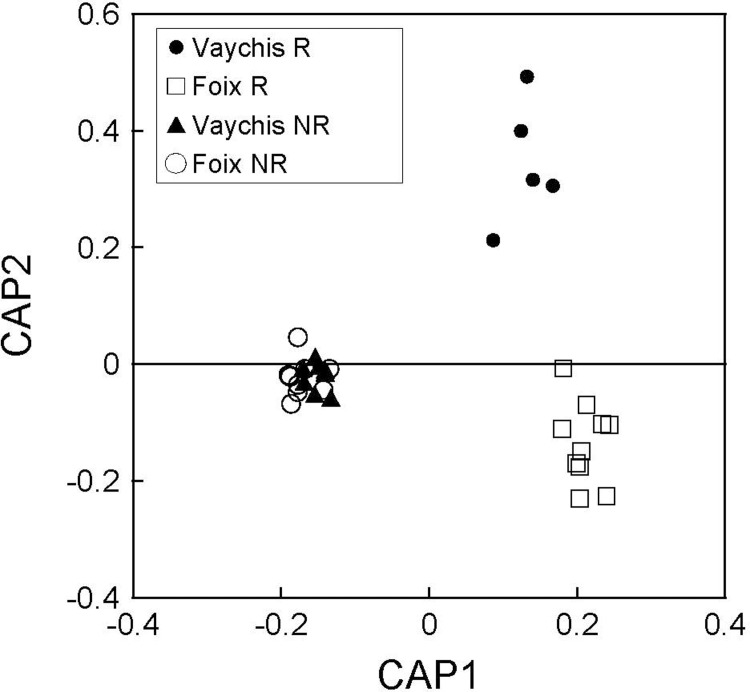
Representation of the first two axes of the canonical analysis of principal coordinates (CAP) showing classification of the femoral secretions of male P. liolepis of two populations in the French Pyrenees sampled in two seasons.